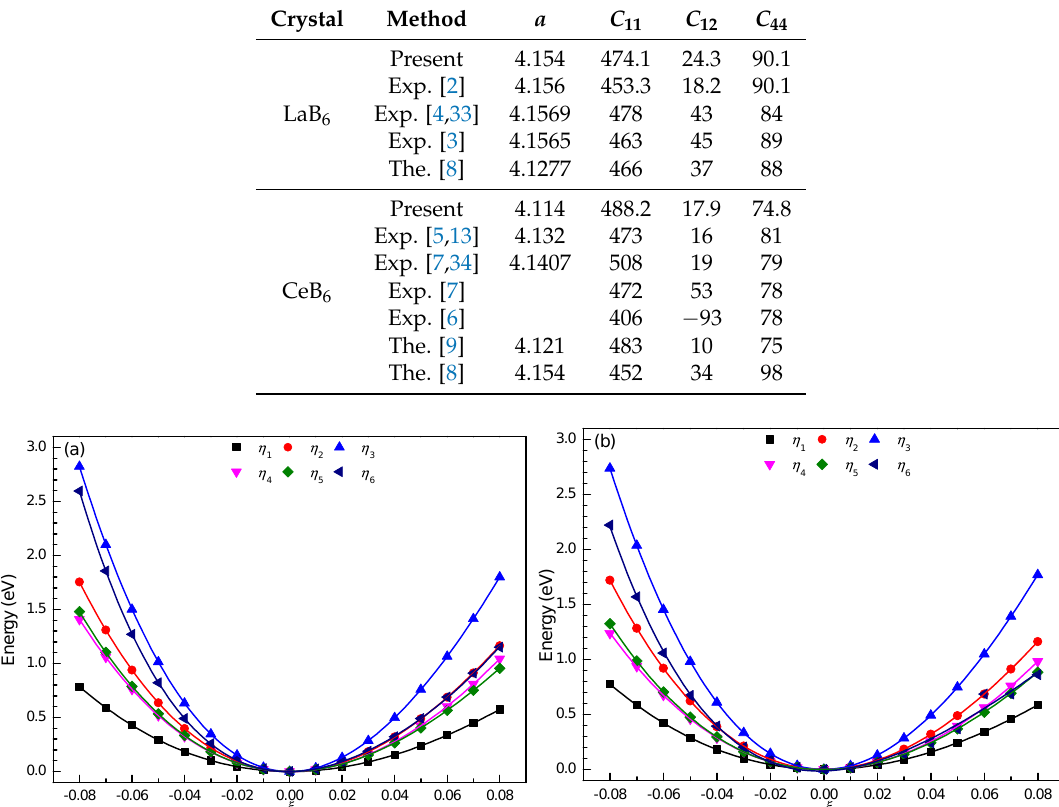
Table 2. Lattice parameter a (in Å) and elastic constants C ij (in GPa) of LaB 6 and CeB 6 .